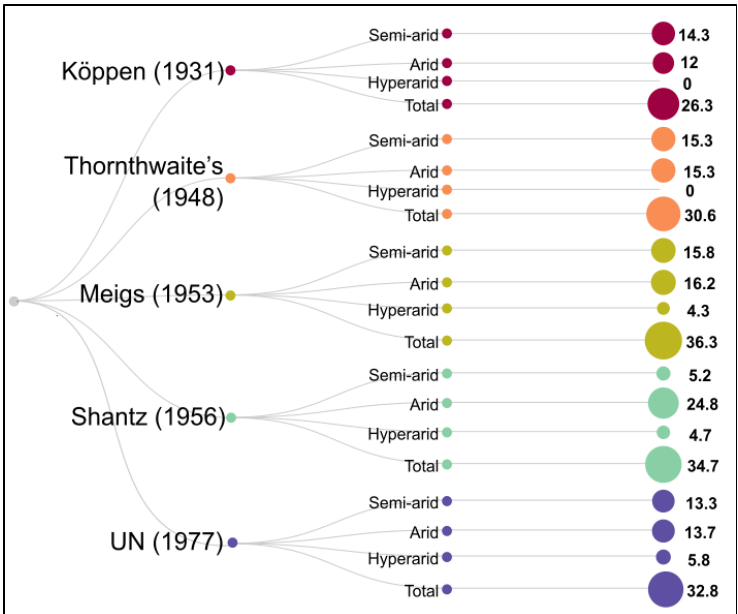
Figure 1. Distribution of arid zones (% of the global land area depicted in the size of the bubbles) according to different classifications (depicted through different colours); modified from [8,13–16].